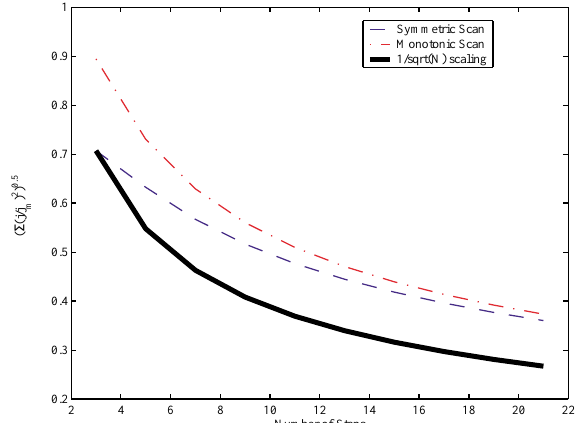
FIG. 1. (Color) (cid:6) P (cid:3) j (cid:2) j m (cid:4) 2 (cid:7) 2 0.5 as a function of the number of steps. Both symmetric scans (blue dashed line) and monotonic scans (red dot-dashed line) are considered. Also shown is the expected behavior of symmetric scans for 1 (cid:2)(cid:3) number steps (cid:4) 0.5 scaling (black heavy solid